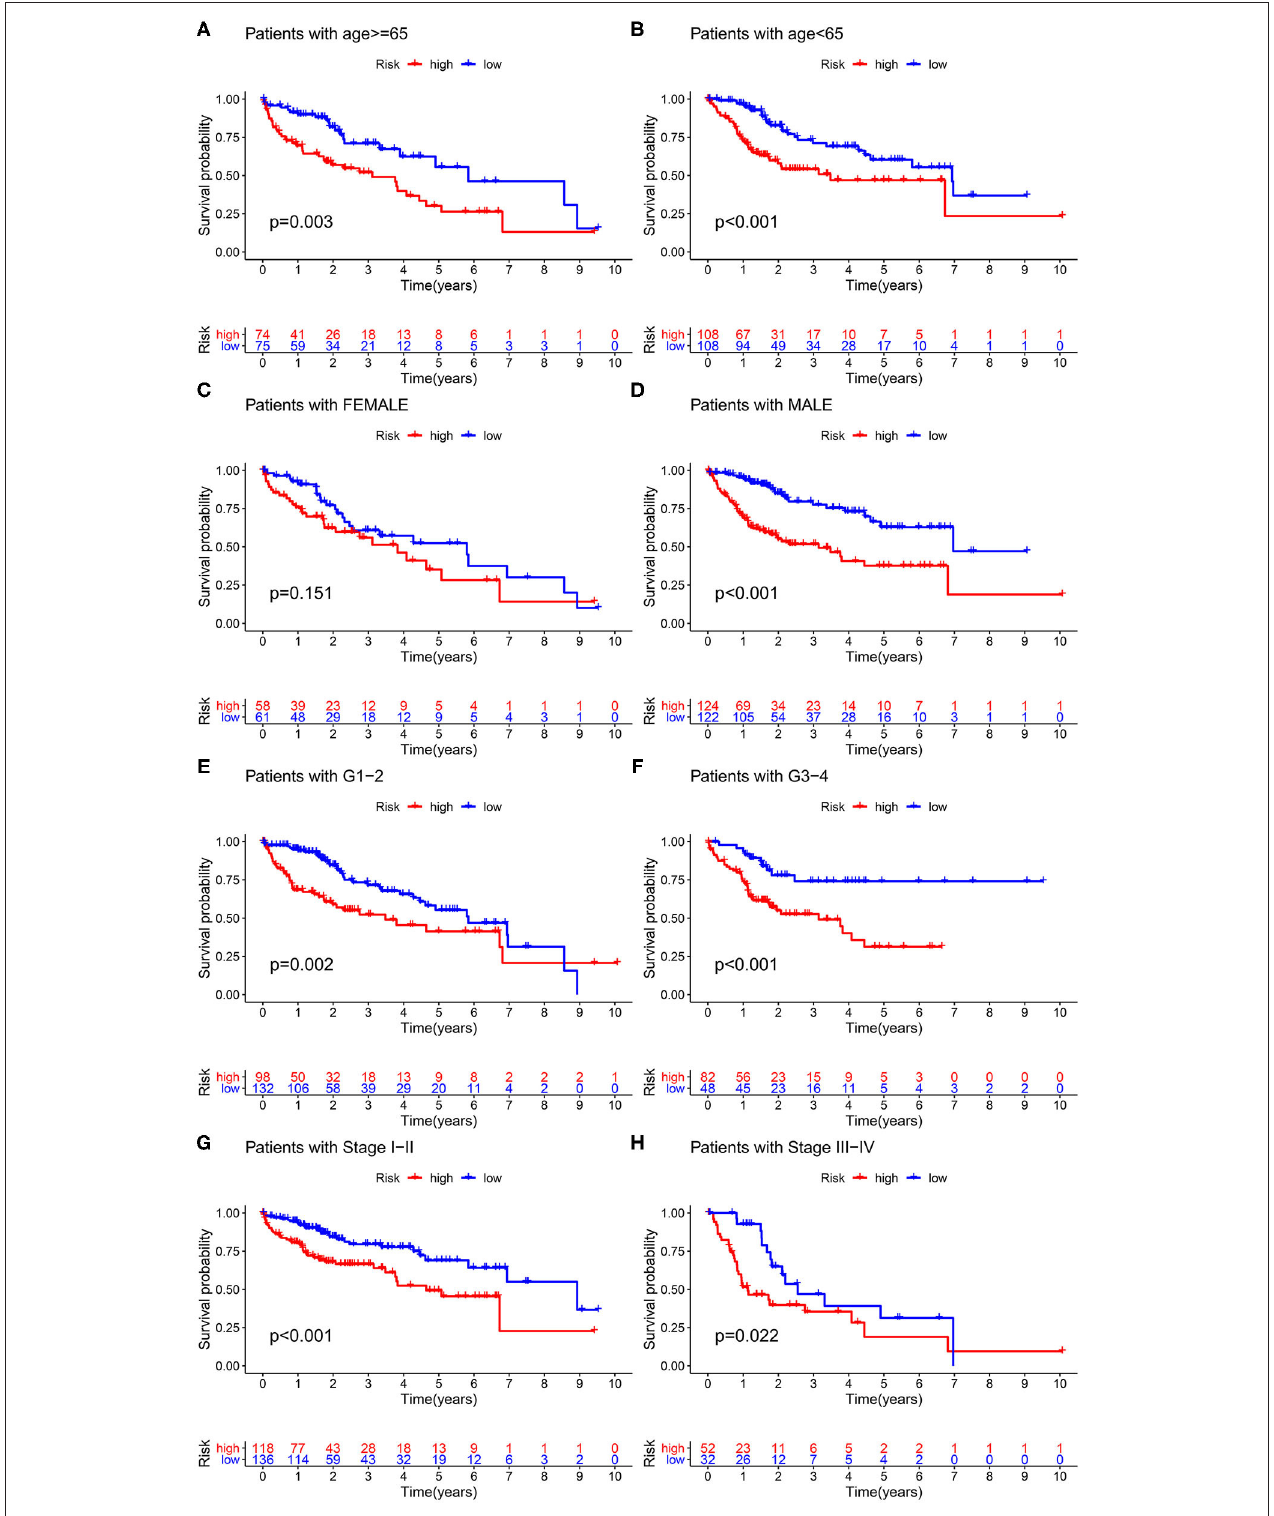
FIGURE 6 | Clinicopathological characteristics analysis. Survival probability stratified by age (A,B) , gender (C,D) , grade (E,F) , and stage (G,H) .